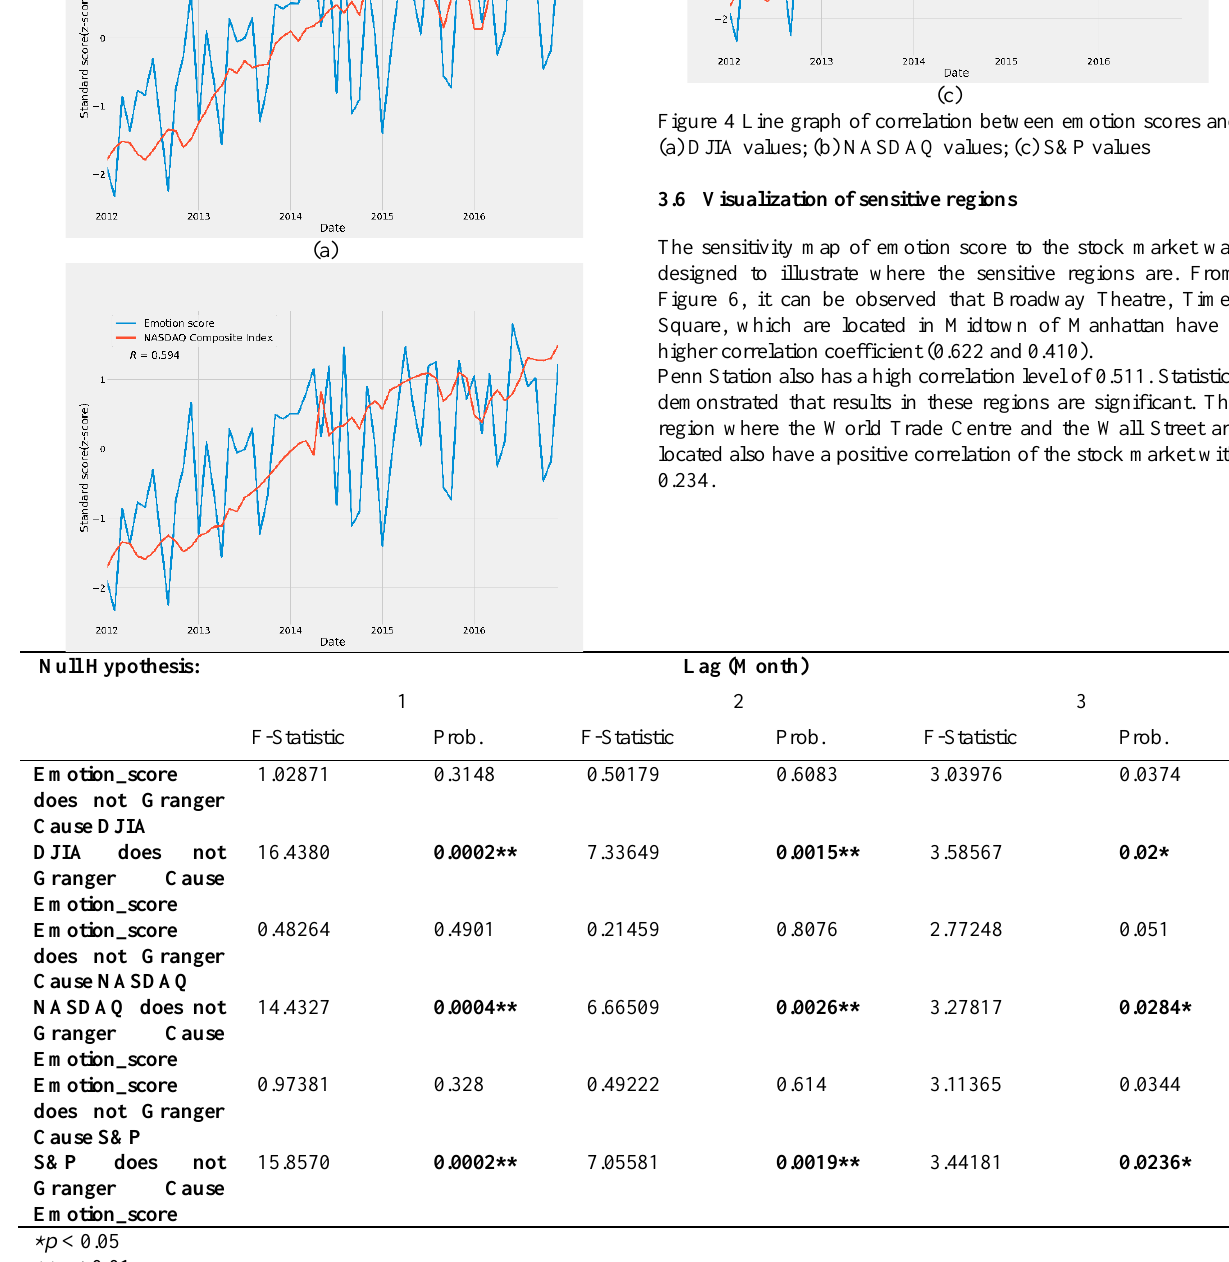
Table 2 Granger Causality Analysis